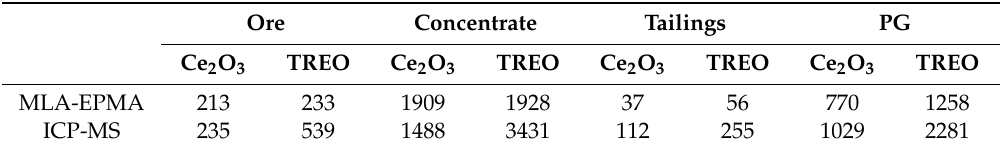
Table 13. The comparison of the measured data of Ce 2 O 3 and TREO for four di ff erent samples by ICP-MS and MLA-EPMA methods (mg /